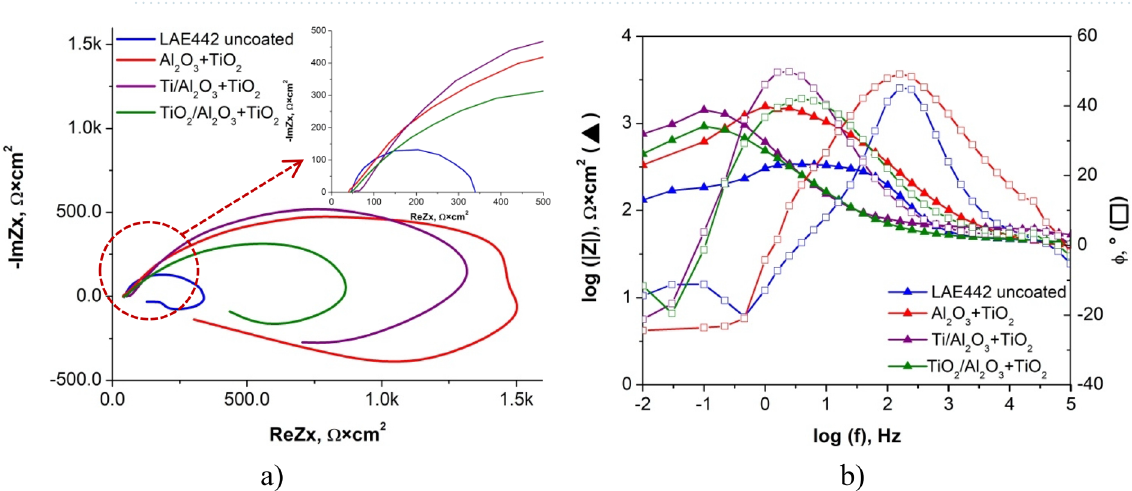
Figure 14. Results of electrochemical impedance spectroscopy (EIS) for uncoated and coated AE42 alloy substrate: ( a ) the Nyquist representation, ( b ) the Bode representation.